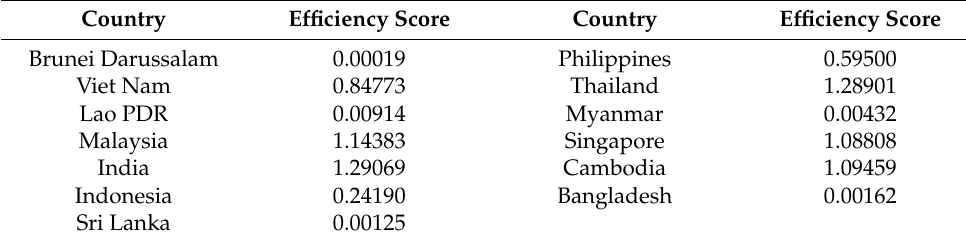
Table A2. Super-SBM model results.